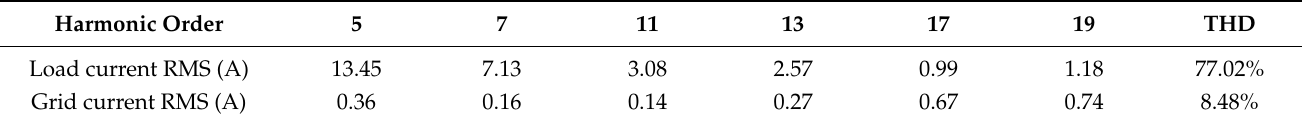
Figure 19. Effects on compound control (CH1—load current containing capacitor; CH2—SAPF cur- rent; CH3—grid current) ( a ) when K p = 0; ( b ) when K p = 1.5.